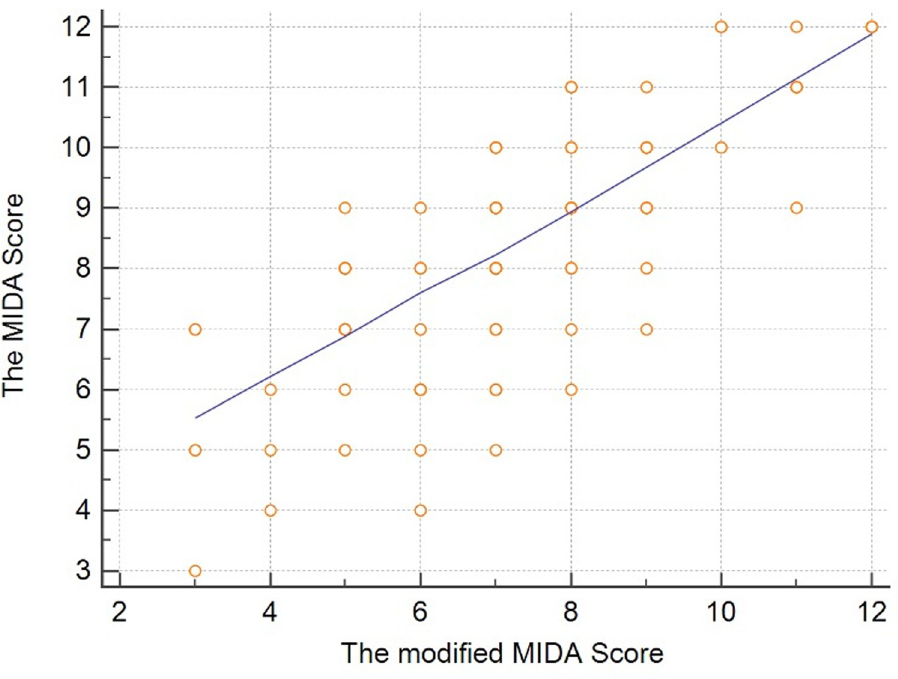
Fig 2. Scatter diagram showing the linear relationship between the original and modified MIDA score.